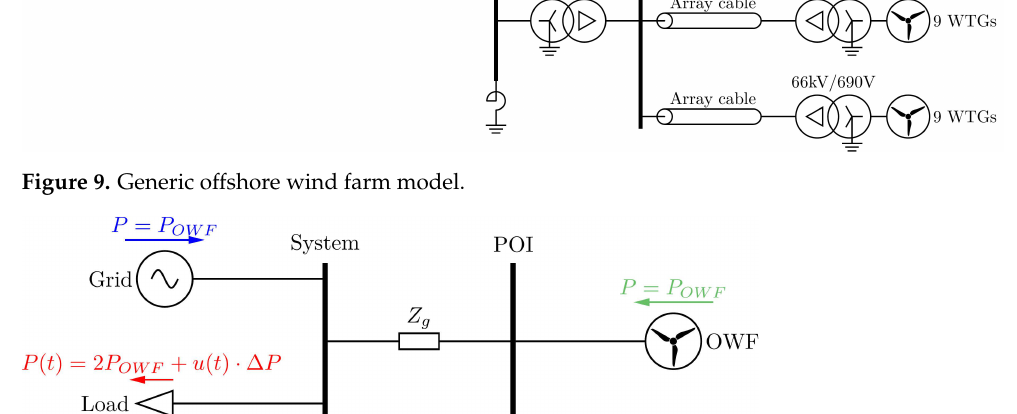
Figure 10. Aggregated power flow